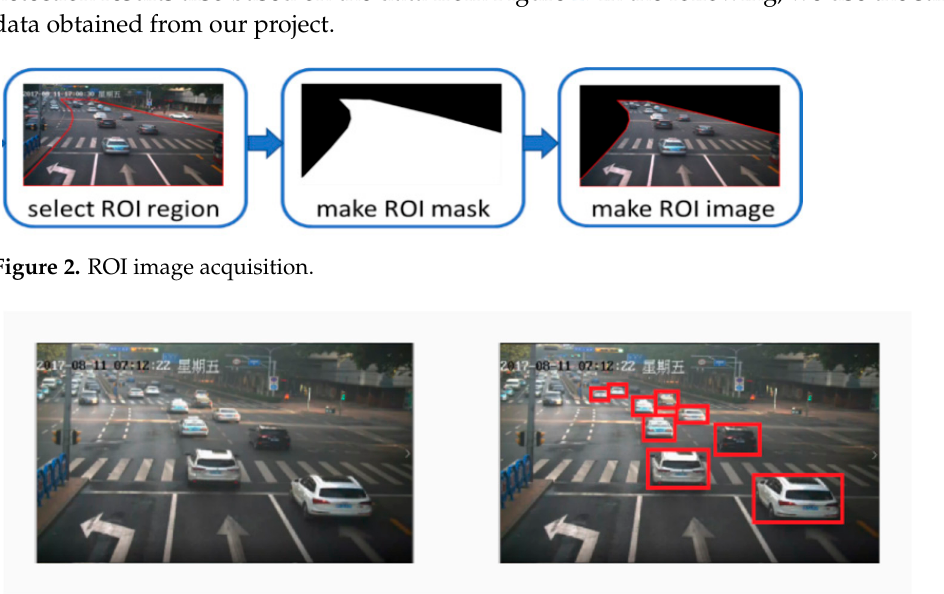
Figure 3. YOLOv3 target detection results.